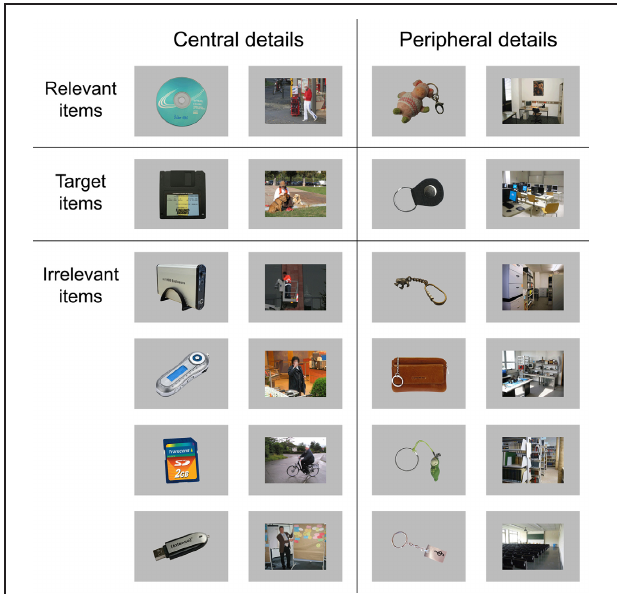
FIGURE 1 | List of all stimuli that were presented during the Concealed Information Test (CIT) in the current study. Note that all faces were blurred for this illustration to prevent identification of the depicted